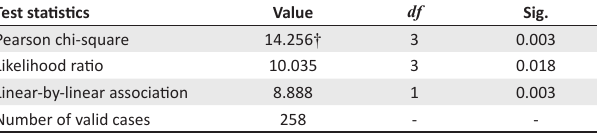
FIGURE 5: (a, b) Frequency distribution of male- and female-headed household’s vulnerability index. TABLE 5: Chi-square tests to understand association between vulnerability status and gender.